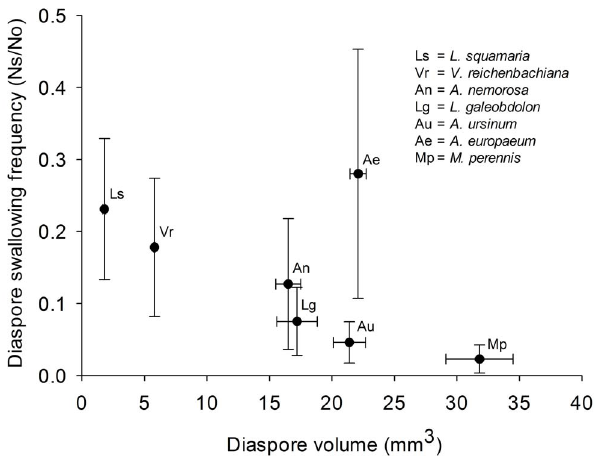
Figure 4. Relationship of diaspore volume and the dispersal potential. Relationship between diaspore volume and the dispersal potential of diaspores by gastropods described as the number of diaspores swallowed (Ns) of the number of diaspores offered (No) to all gastropod individuals. Results are given as mean 6 standard error (SE).